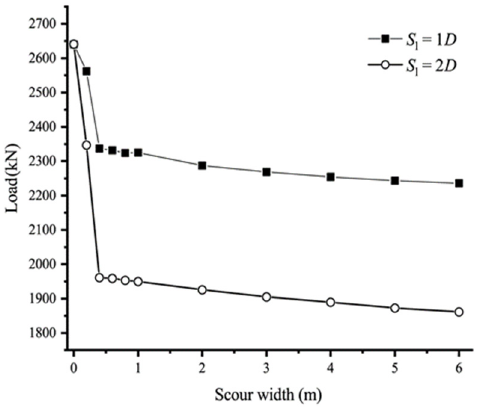
Figure 7. Pile lateral load capacity with scour width.